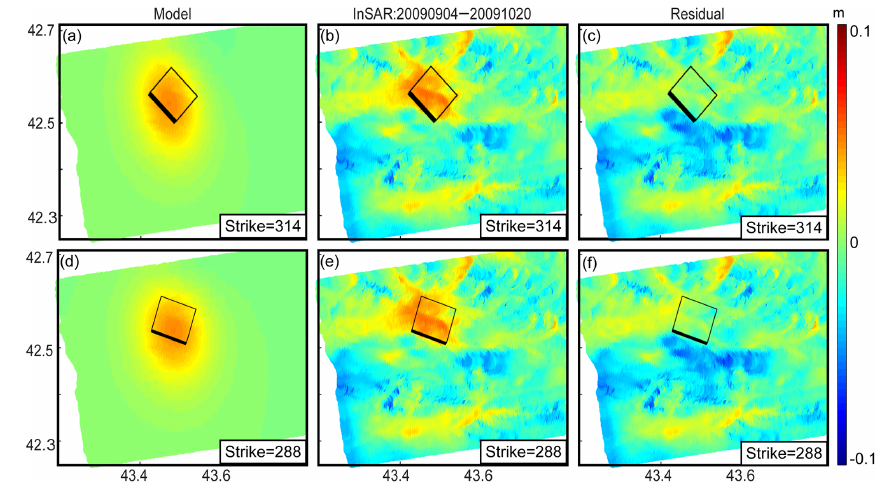
Figure 3. Preliminary results of our forward modeling. (a) Model based on the CMT solution, (b) InSAR interferogram and (c) residual (right) between the observations (b) and model (a) . (d) Same model as in the previous case, but with a different strike value, (e) InSAR interferogram and (f) residual between the observations (e) and model (d) . The black frames show the projection of fault